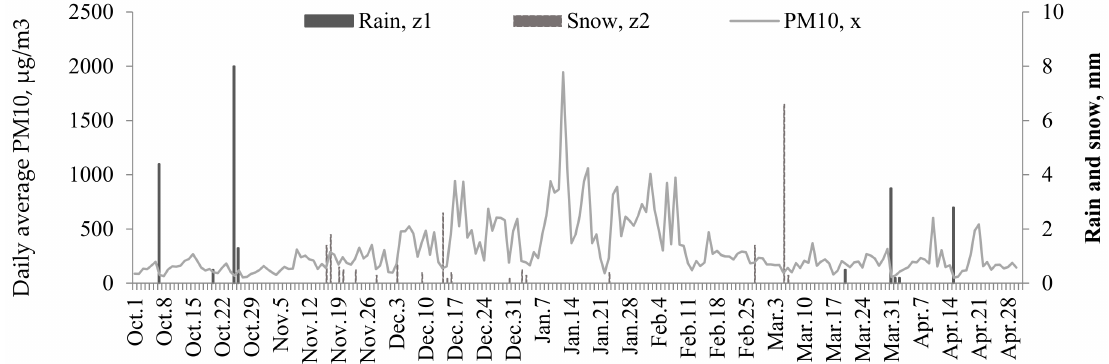
Figure 4. Daily average airborne dust (PM 10 ), daily total rain and snow rate.